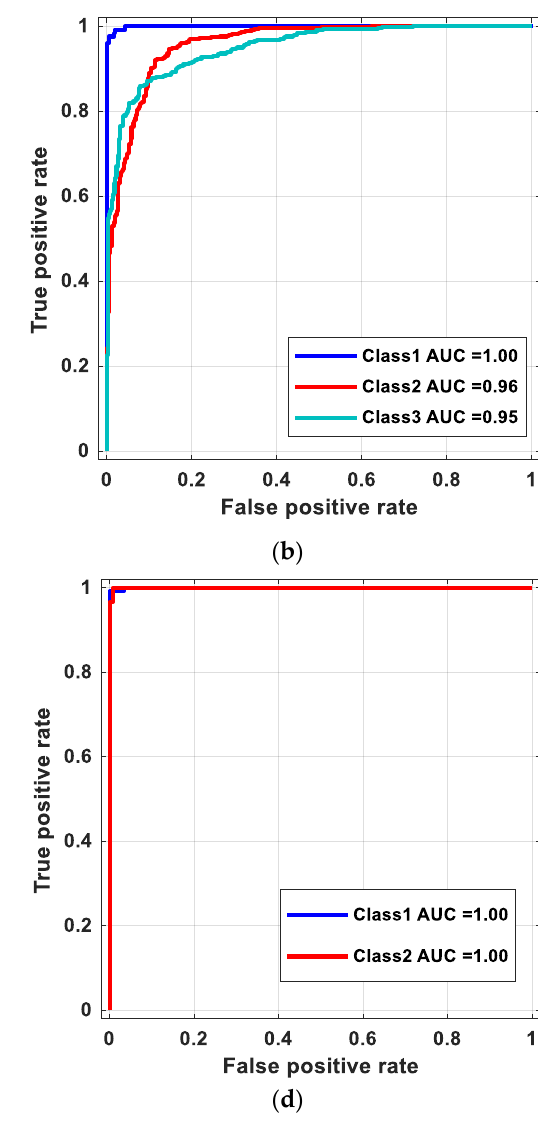
Figure 8. ROC curves of proposed model for datasets used: ( a ) DB1, ( b ) DB2, ( c ) DB3 and ( d ) DB4.